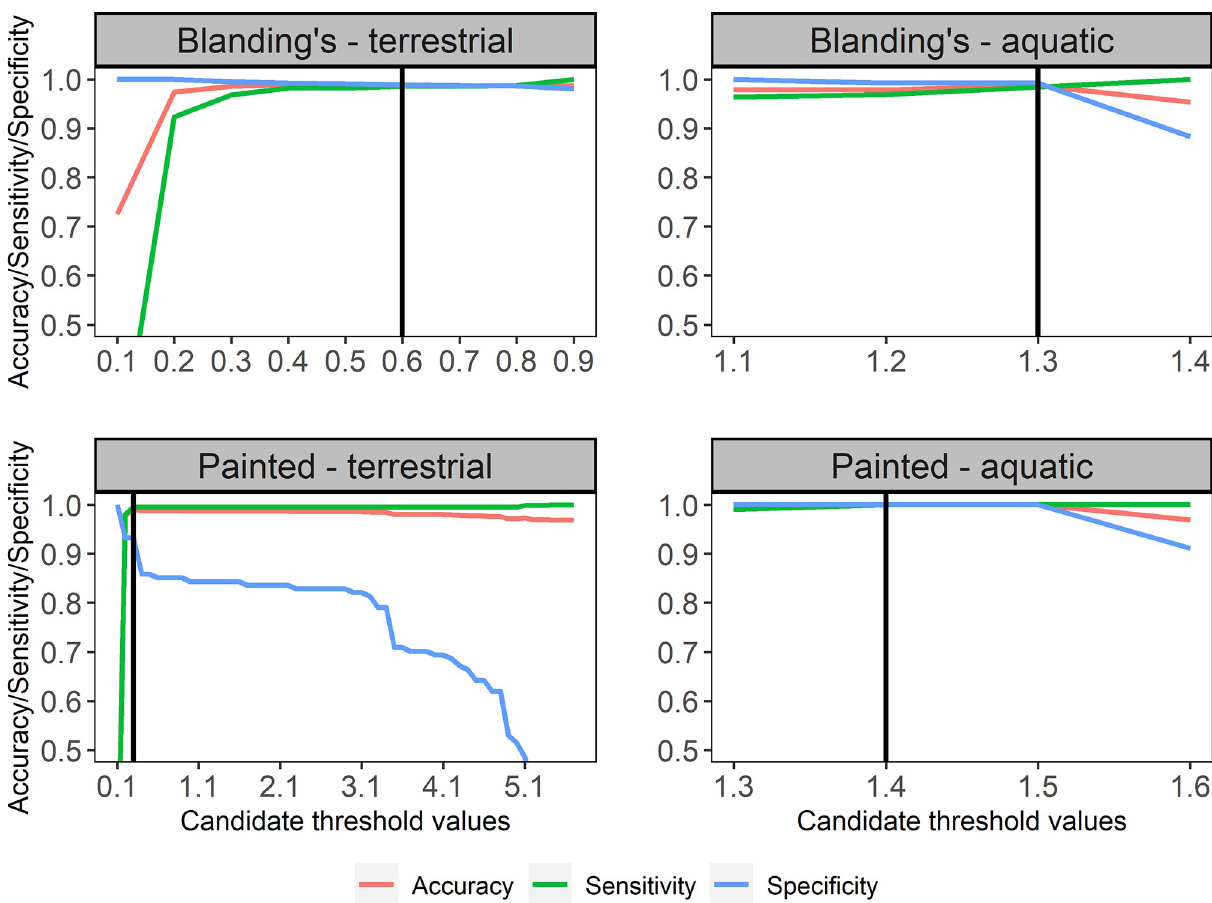
Fig 3. Qualitative selection of the most suitable threshold value (vertical line) relative to accuracy, sensitivity and specificity for Blanding’s turtles and Painted turtles, using accelerometer data sampled at 1 Hz.